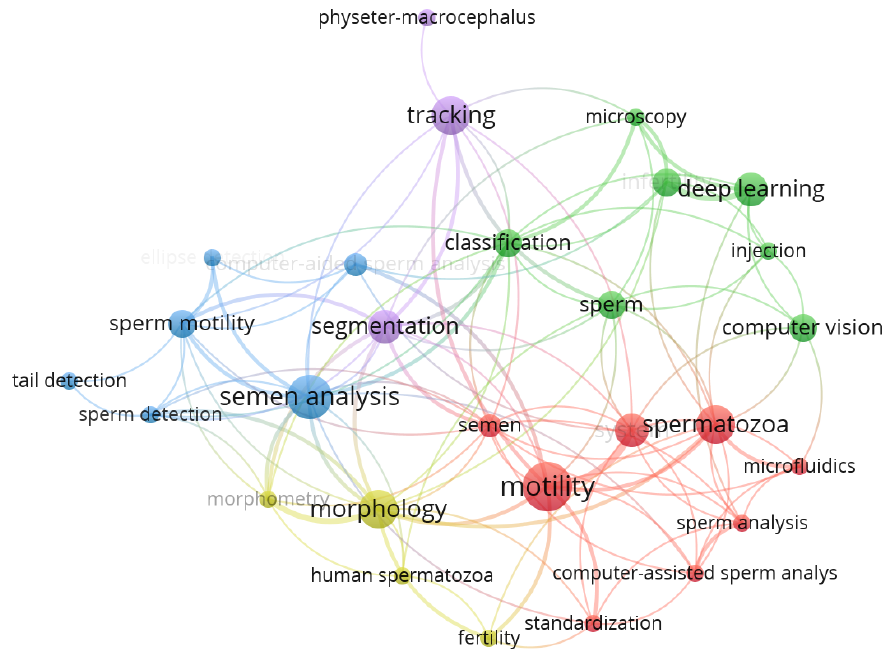
Figure 2. Keyword